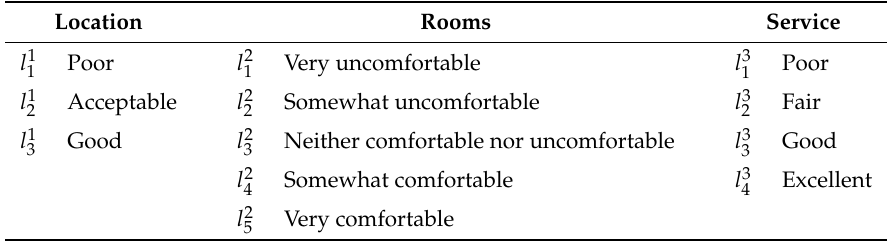
Table 1. OQSs for each